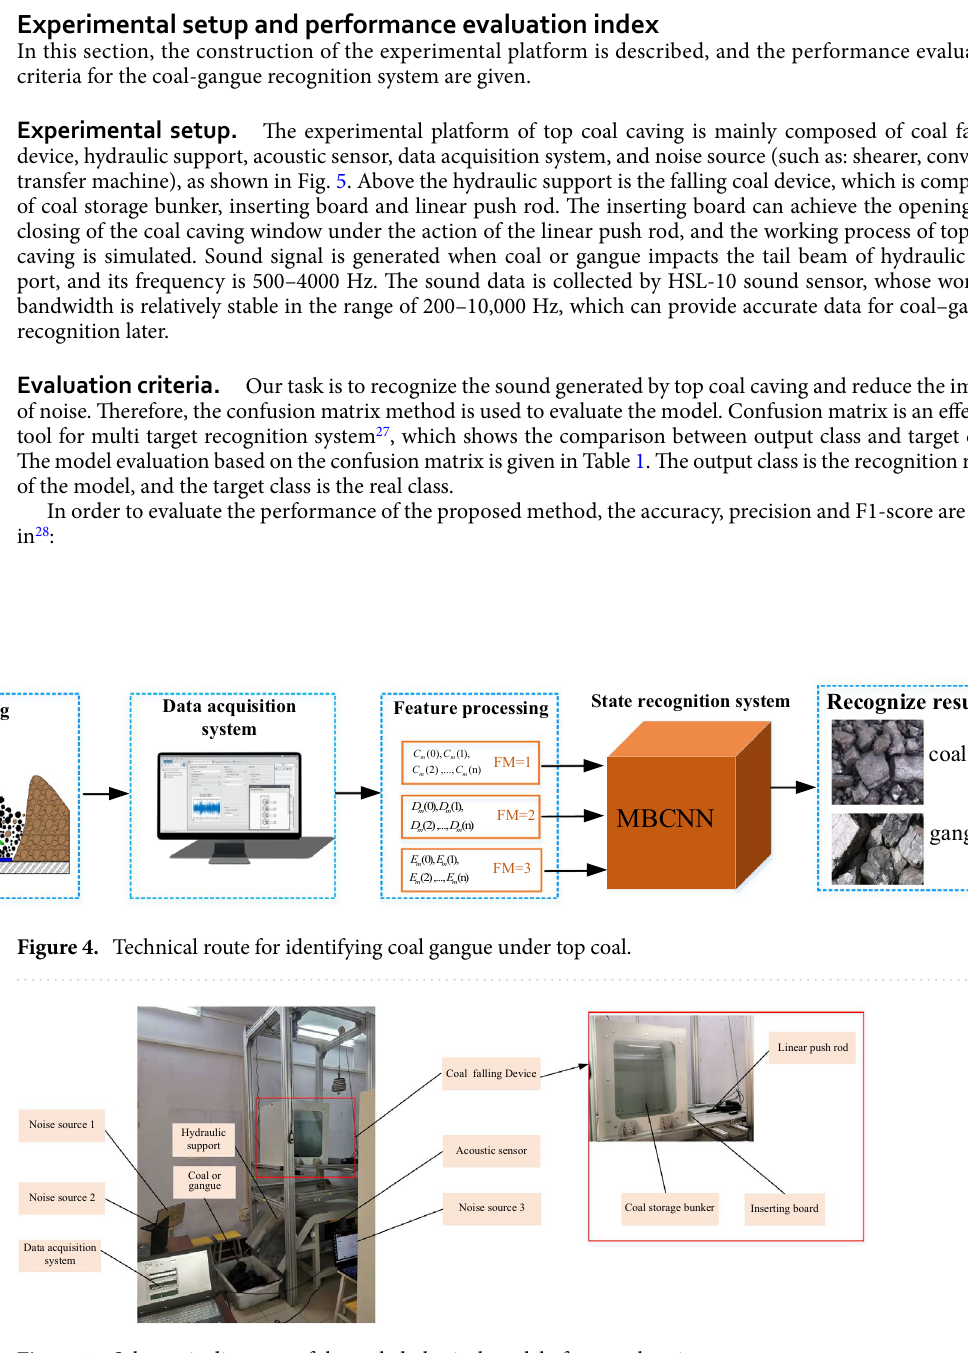
Figure 5. Schematic diagrams of the scaled physical model of top coal